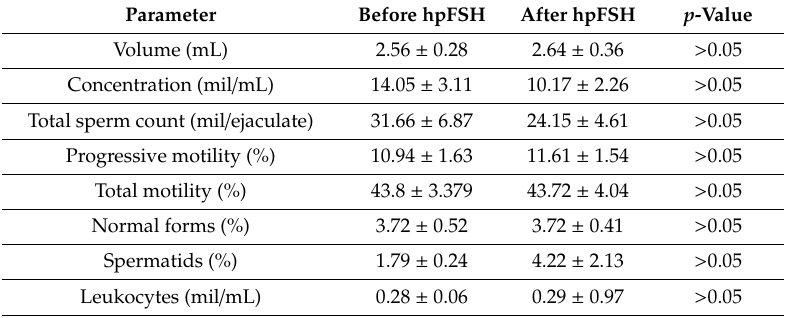
Table 2. Conventional sperm parameters before and after hpFSH treatment in non-responder patients.